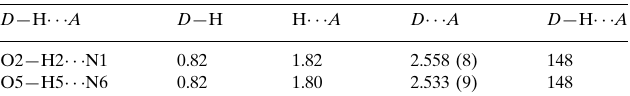
Hydrogen-bond geometry (A˚ , (cid:2)